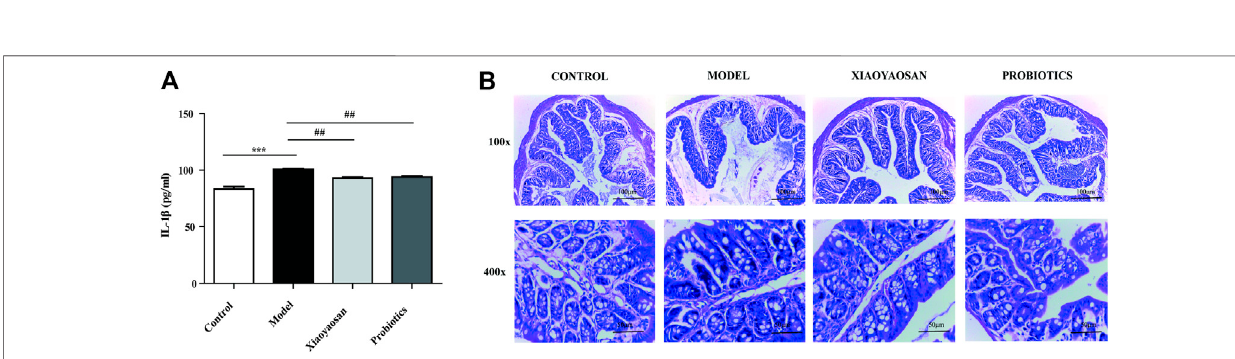
Frontiers in Pharmacology |